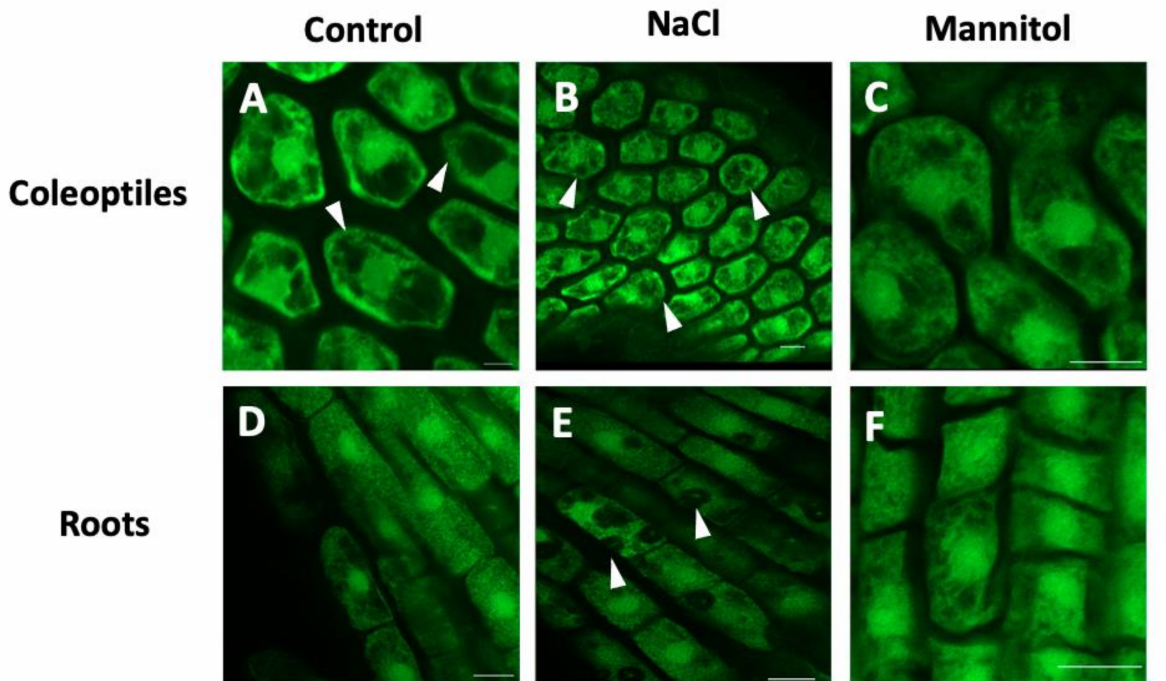
Figure 2. Organization of microtubules in coleoptiles and barley roots under osmotic stress. The images ( A , D ) show the distribution of the microtubules in the central plane of the cells of the coleoptile apex and the radical apex in roots without treatment. The distribution of the microtubules was disrupted when cells of coleoptiles and root were treated with NaCl (100 mM, images B , E ) or mannitol (200 mM, images C , F ). Fluorescence-labeled microtubules were visualized with a confocal laser microscope (Nikon Eclipse Ti). Scale bar = 20 µ